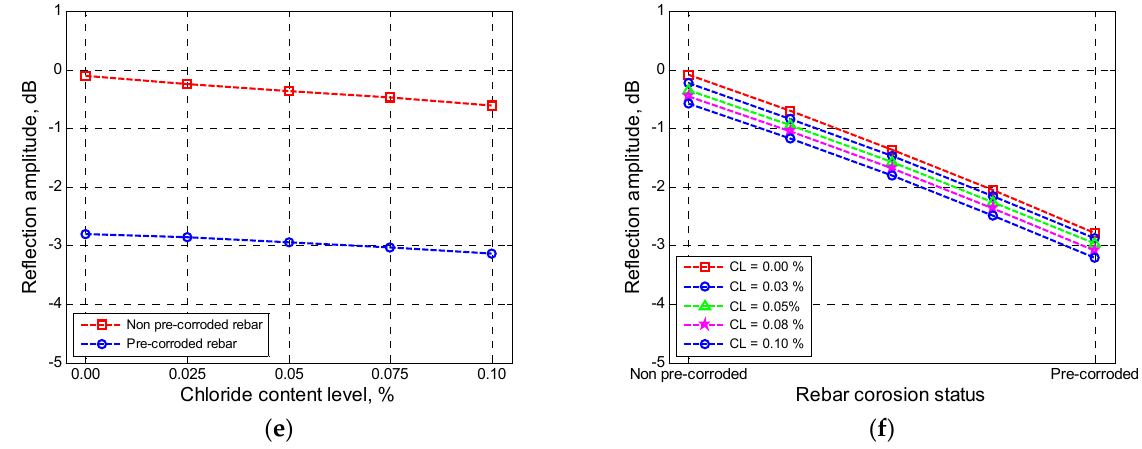
Figure 7. Effect of chloride contamination level ( a – c ) and rebar corrosion status ( d – f ). Sensitivity analysis was conducted to examine the effect of input factors on the output using a one-at-a-time (OAT) method. In order to do that, the value of one factor was selected from the Low, ML, Mean, MH, and High, while the value of the other factors remain at the mean. Measure the output and then repeat the process for the rest of the parameters. The results are depicted in Figure 8. As can be seen, the temperature variable (T) was the most influential variable on the output of the predictive model, followed by the chloride contamination level parameter (CL). In the meantime, the relative humidity variable (RH) was found to have limited influence on the prediction capacity of the pro- posed DBN model. The finding was in line with the previous study [25]. It is noted that the impact of uncertainty of the input parameters was not considered in this study.